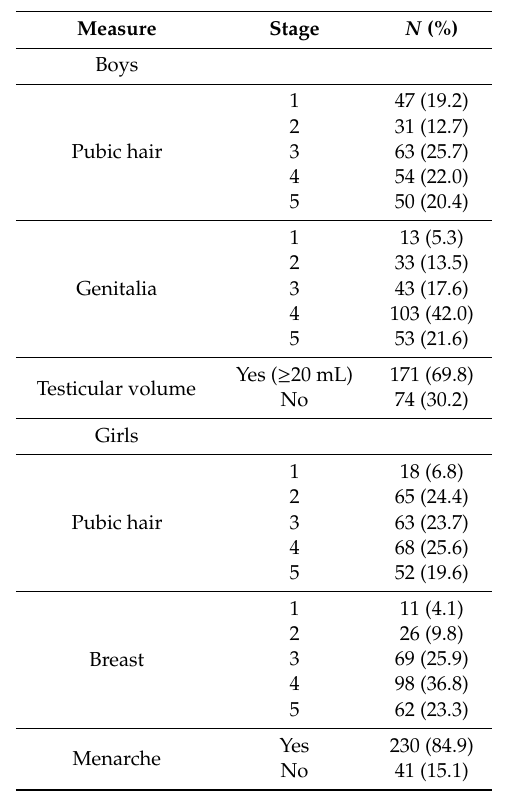
Table 2. Distribution of physician-assessed secondary sex characteristics a .